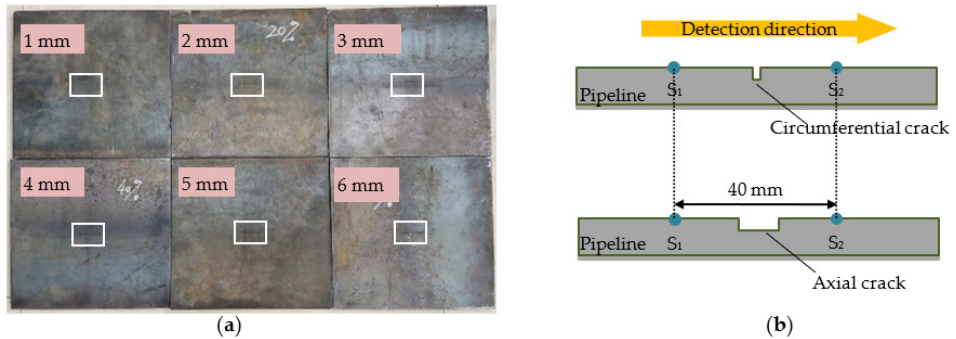
Figure 10. ( a ) Experimental pipelines with different depths of cracks; ( b ) schematic diagram of sensor movement path.